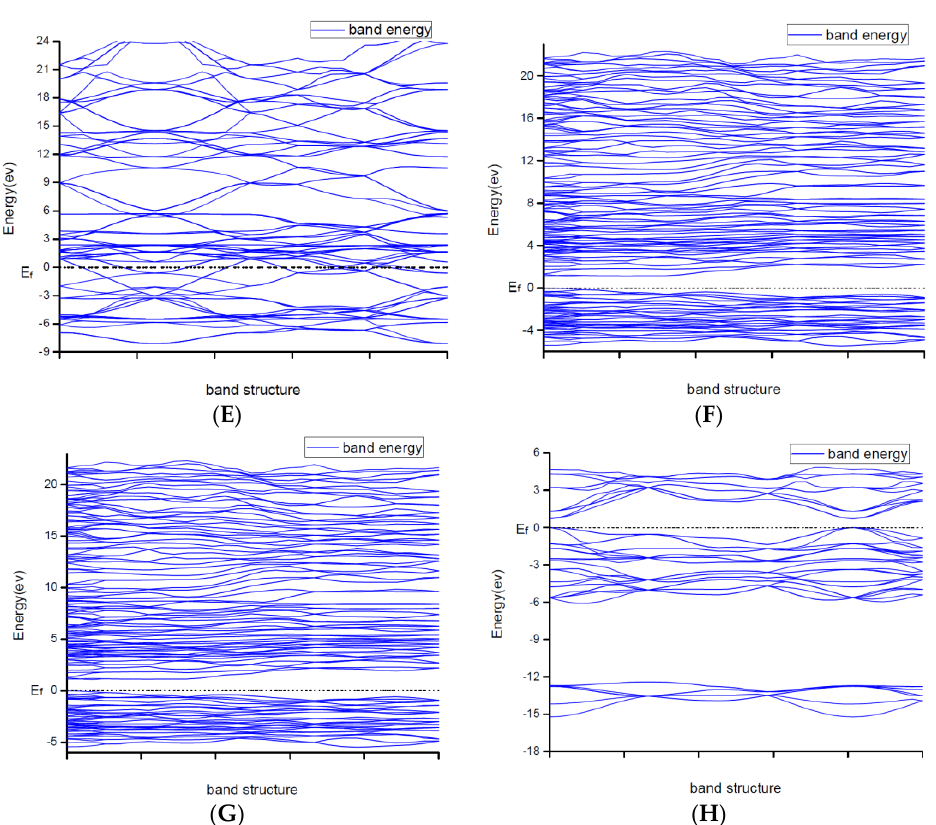
Figure 2 . Band structures of ( A ) ZrN with space group Fm3 m; ( B ) ZrN with space group P6 3 mc; ( C ) TiN; ( D ) Ti 2 N with space group P4 2 /mnm; ( E ) Ti 2 N with space group I4 1 /amdz; ( F ) Zr 3 N 4 with space group Pna2 1 ; ( G ) Zr 3 N 4 with space group Pnam; ( H ) Zr 3 N 4 with space group I4 3d.